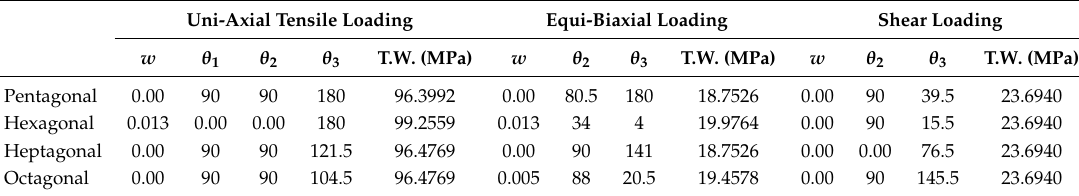
Table 12. All optimal values of design parameters for another cutout ( c = 1).